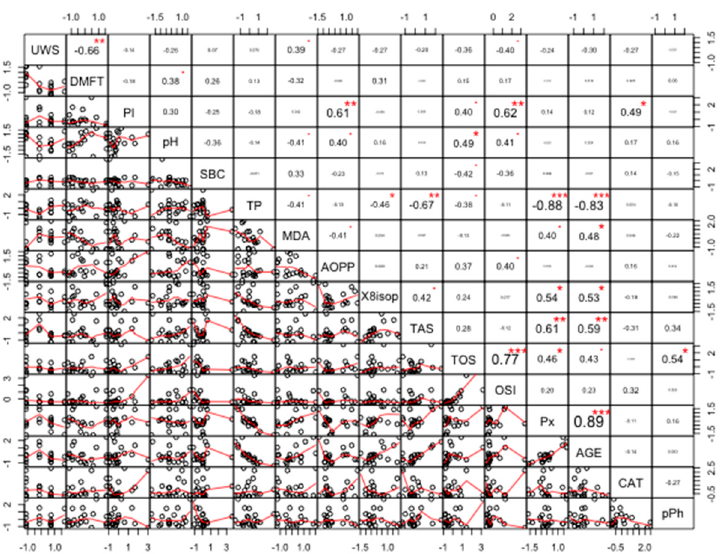
Figure 14. Coefficients of correlation between parameters measured in the saliva of women with the BRCA1 mutation (PZ). PZ, generally healthy patients with the BRCA1 mutation; AOPP, advanced oxidation protein products; TP, total protein; OSI, oxidative stress index; TOS, total oxidant status; TAS, total antioxidant status; CAT, catalase activity; pPh, total phenolic content; Pl.I score, Plaque Index; DMFT, decay, missing, filled teeth; UWS, unstimulated whole saliva; SBC, salivary buffer capacity; 8-isop, concentration of 8-isoprostane; MDA, concentration of malondialdehyde; AGE, advanced glycation end-products; SBC, buffer capacity of saliva; Px, activity of salivary peroxidase. * p < 0.05; ** p < 0.01; *** p < 0.001.